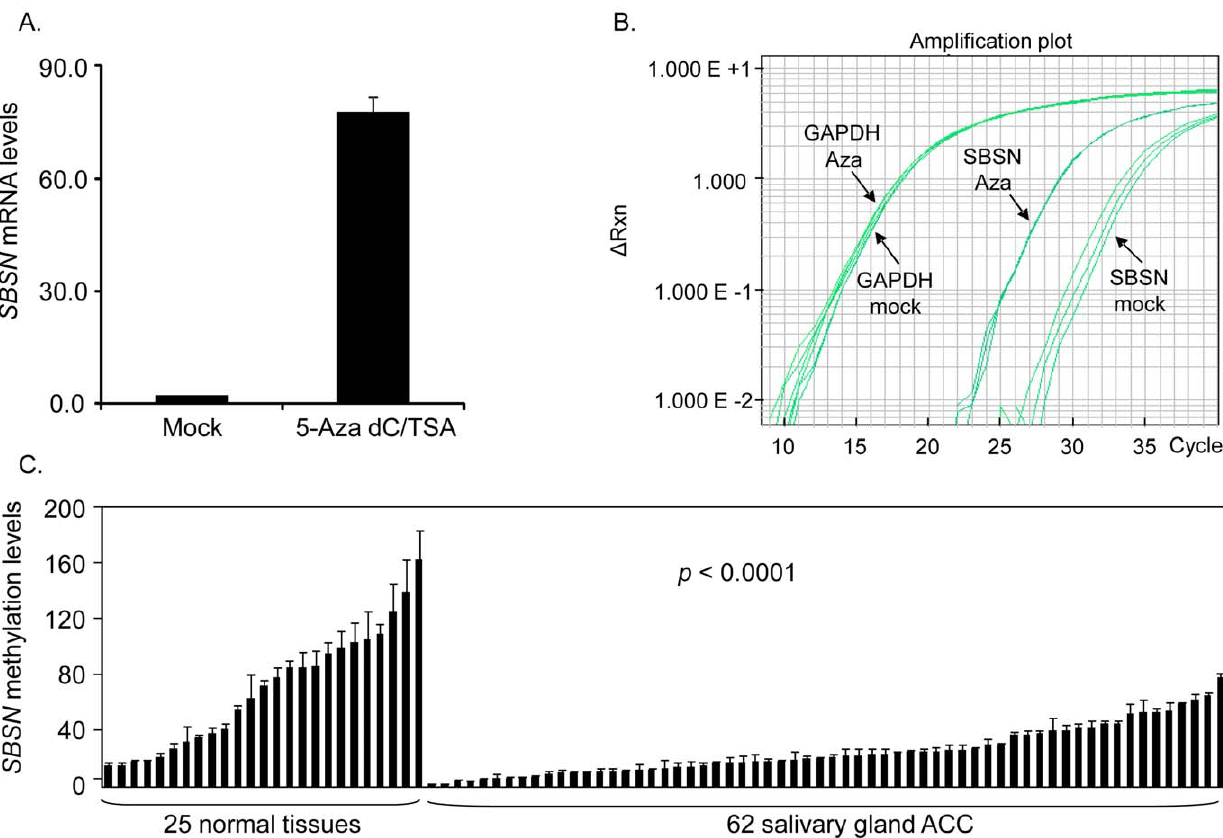
Figure 1. SBSN is hypomethylated in primary ACC samples, and its expression is induced by CpG island demethylation in SACC83. A. We first confirmed 5-aza-dC/TSA-induced expression of SBSN in SACC83 mRNA levels by qRT-PCR. B. Graph of actual data using TaqMan qRT-PCR analysis. X-axis, amplification cycle numbers; y-axis, D Rn values used to plot signal attributable to the 5 9 nuclease reaction, which reflects the quantity of amplicon. SBSN was amplified between 25–30 cycles in 5-aza-dC/TSA treatment, whereas it was amplified between 30–35 cycles in mock treatment. 5-aza-dC/TSA- or mock-treated samples were loaded in the same amount as indicated by GAPDH . C. qMSP was conducted in a paraffin- embedded ACC cohort, which consisted of 62 ACC samples and 25 normal salivary gland tissues. Significant hypomethylation in SBSN was shown in ACC versus normal salivary gland tissue (p , 0.0001, Student’s t-test). SBSN methylation scores were normalized by b -actin. Error bars indicate the standard